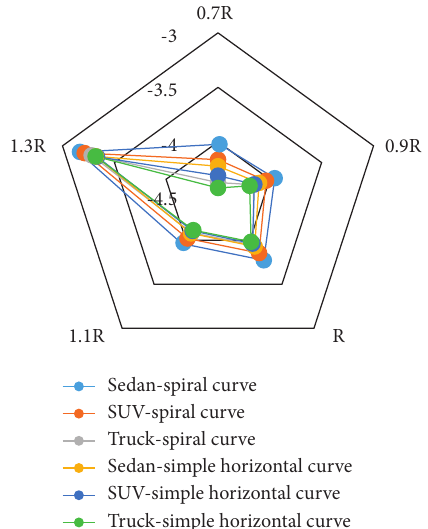
Figure 18: Maximum roll angles in the simple and spiral horizontal curves for various radii, vehicles, and the speed of 100 km/h.